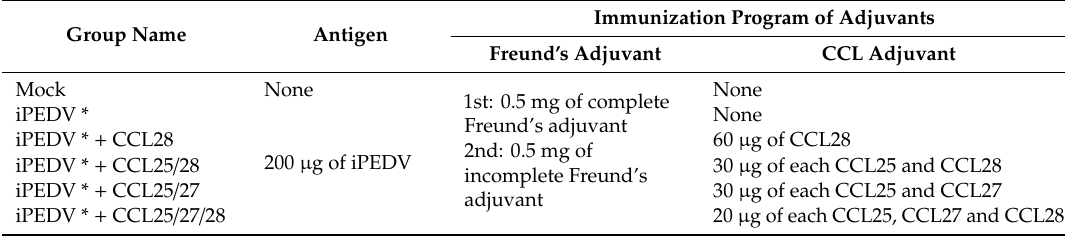
Table 1. Design of immunization programs and animal